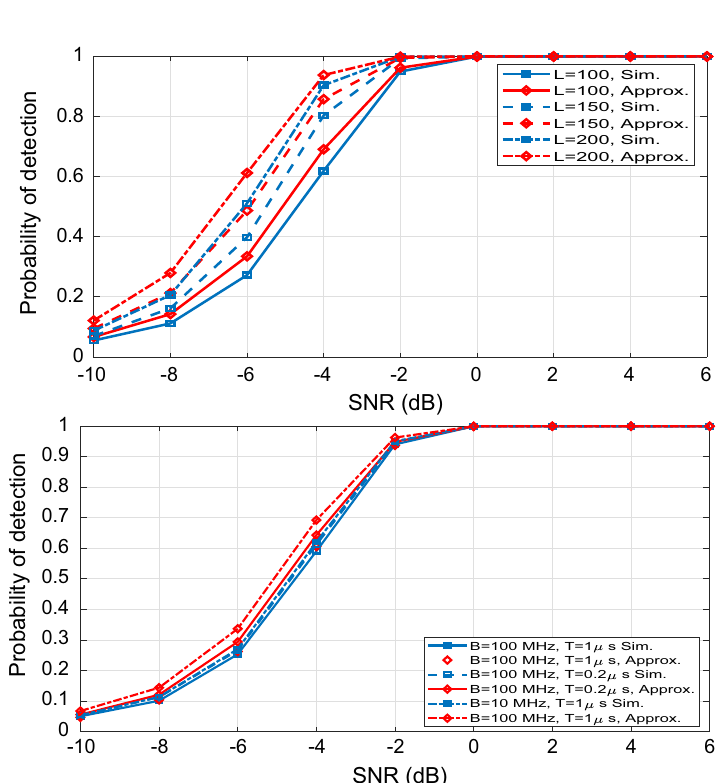
Fig. 5 Probability of detection versus SNR for a-(top)) different L , b-(bottom)) different time-bandwidth